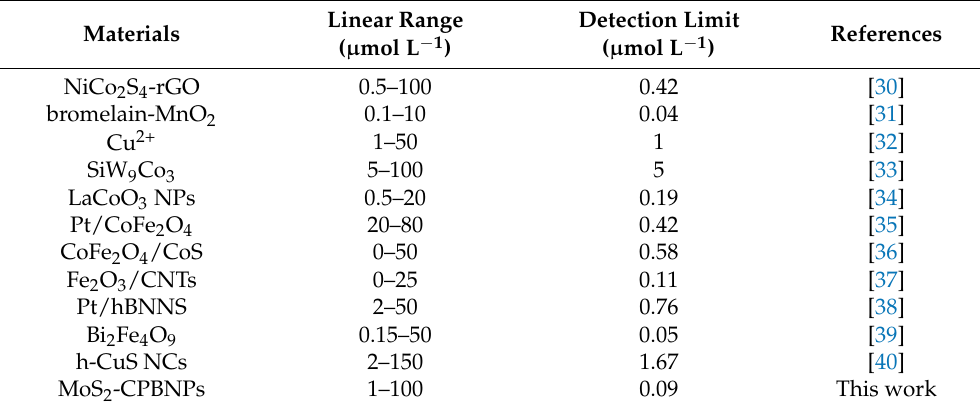
Table 2. Comparison of the performances of colorimetric sensors for the determination of dopamine.